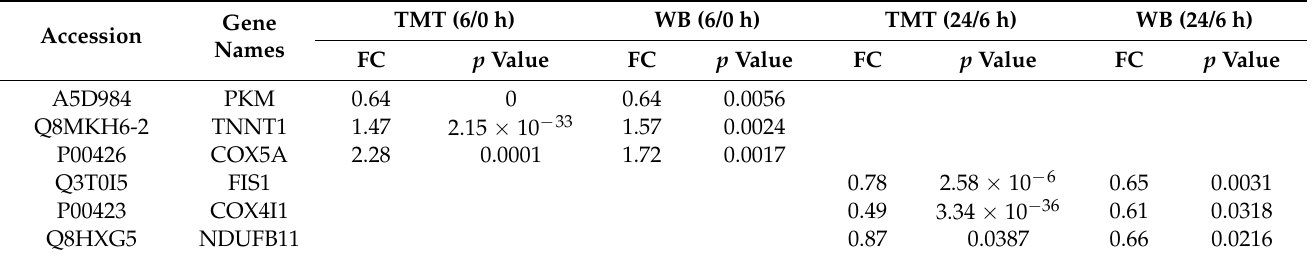
Figure 4. ( A ) Validation of the differentially expressed proteins of 0 h vs. 6 h PM by western blotting. ( B ) Validation of the differentially expressed proteins of 6 h vs. 24 h PM by western blotting. Table 7. Validation of the differentially expressed proteins (PKM, TNNT1, COX5A, FIS1, COX4I1, and NDUFB11) by western